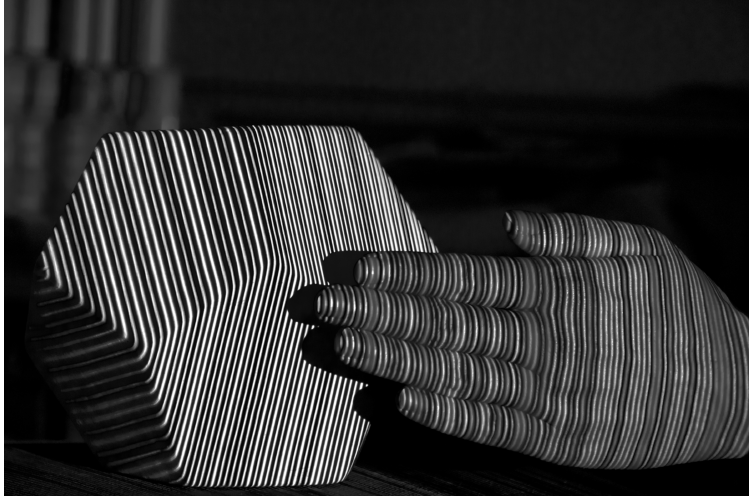
Figure 2. An example of M channel.